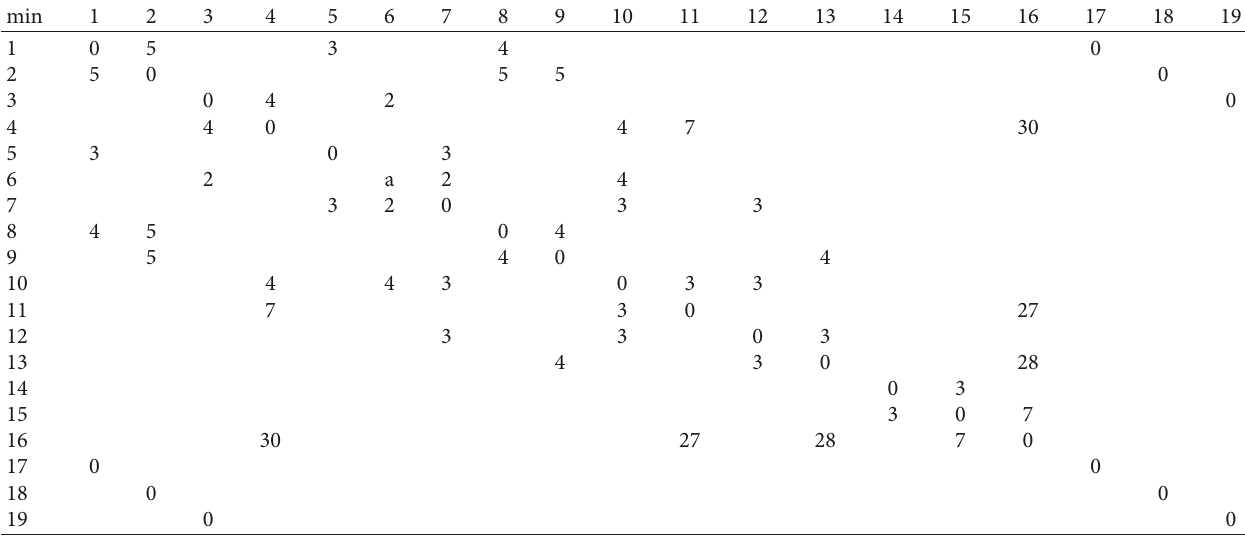
Table 17: The routing time between locations of Group 3.